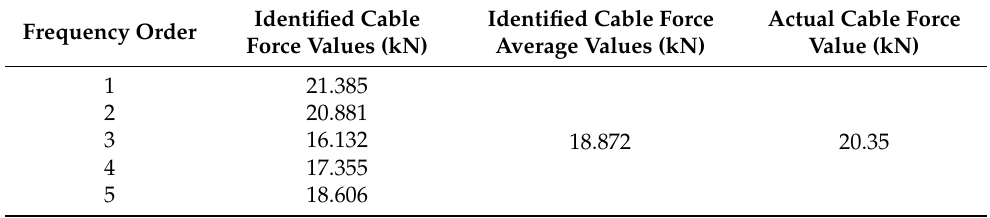
Table 3. Results of frequency detection and cable force calculation of a cable-stayed structure.